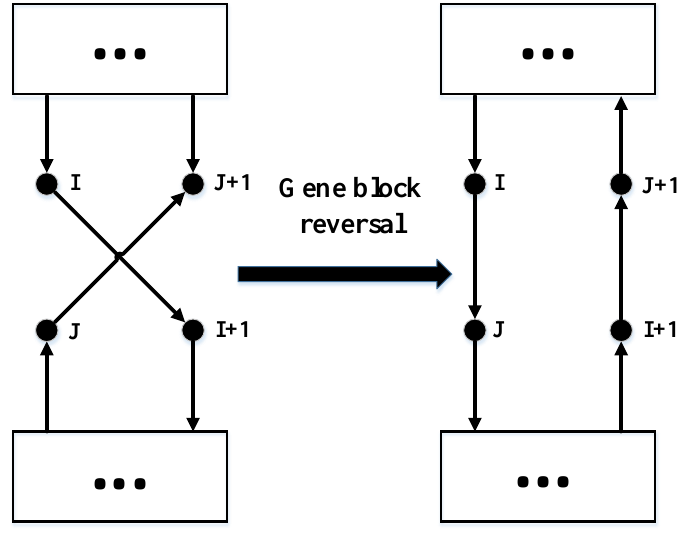
Figure 7. The strategy to delete crossovers in the knowledge based initialization technique